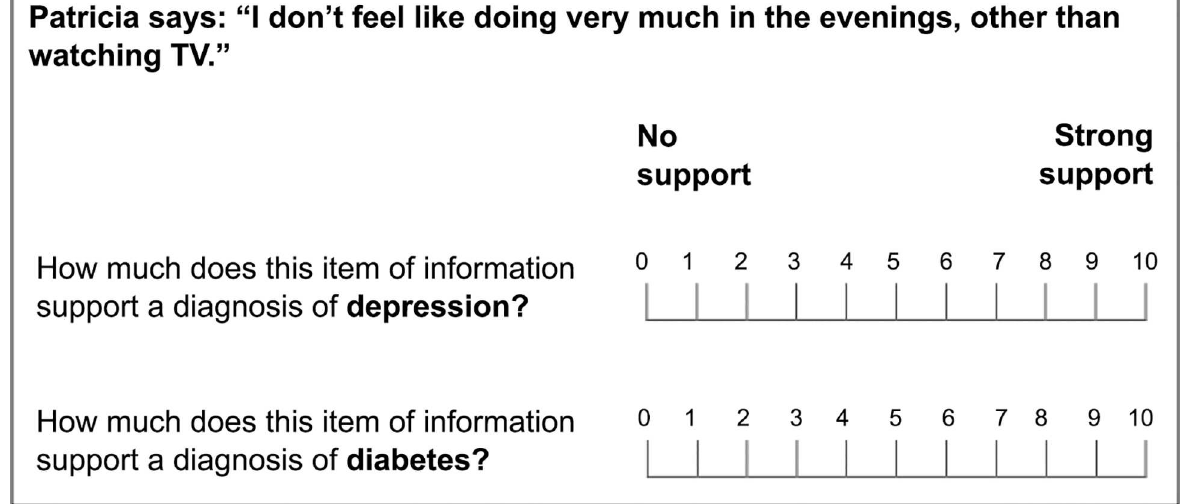
Fig 3. Scalesused to collectratingsof cue diagnosticityin the separate-scalesgroup. The same scales were used by Nurek et al. [21].Participants were requiredto place one markupon each scale. The diagnosisevaluated first was counterbalanced across